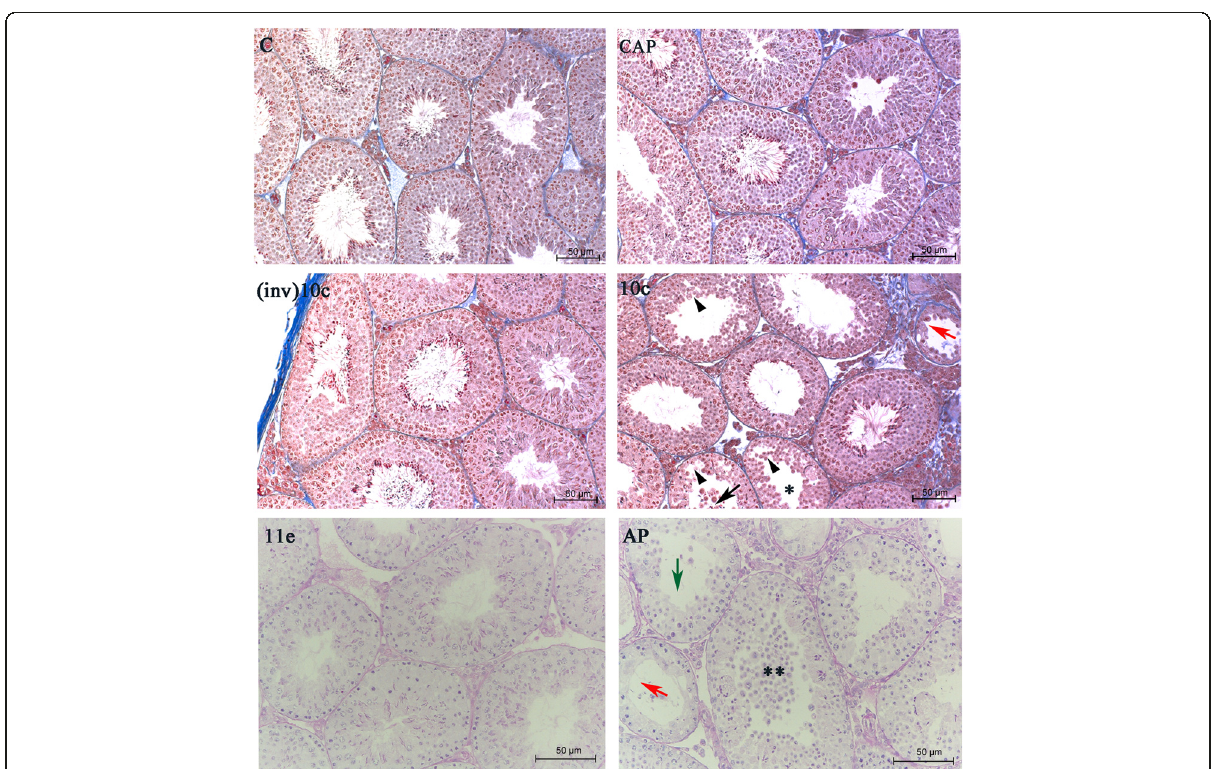
Fig. 1 Effects of angiotensin-converting enzyme (ACE) inhibitors on morphology of the seminiferous epithelium of the mouse testis. Seminiferous tubules of the right testis of control animals treated with saline solution ( C ) and the left testis of mice treated with captopril ( CAP ), (inv)BPP-10c [ (inv)10c ], BPP-10c ( 10c ), BPP-11e ( 11e ) or BPP-AP ( AP ). Normal structure of tubules [ C , CAP , (inv)10c , and 11e ], germ cells in the lumen oftubules ( 10c , black arrow), degenerative tubule ( 10c and AP , red arrow), ruptures in the epithelium ( 10c , arrowheads), absence of round spermatids in stage V of the seminiferous epithelium cycle ( 10c , asterisk), round spermatids in the adluminal compartment ( AP , double asterisk) and tubules with few germ cells, green arrow). Staining: Mallory ’ s Trichrome [ C , CAP , (inv)10c and 10c ] and PAS-Hematoxylin ( 11e and AP )